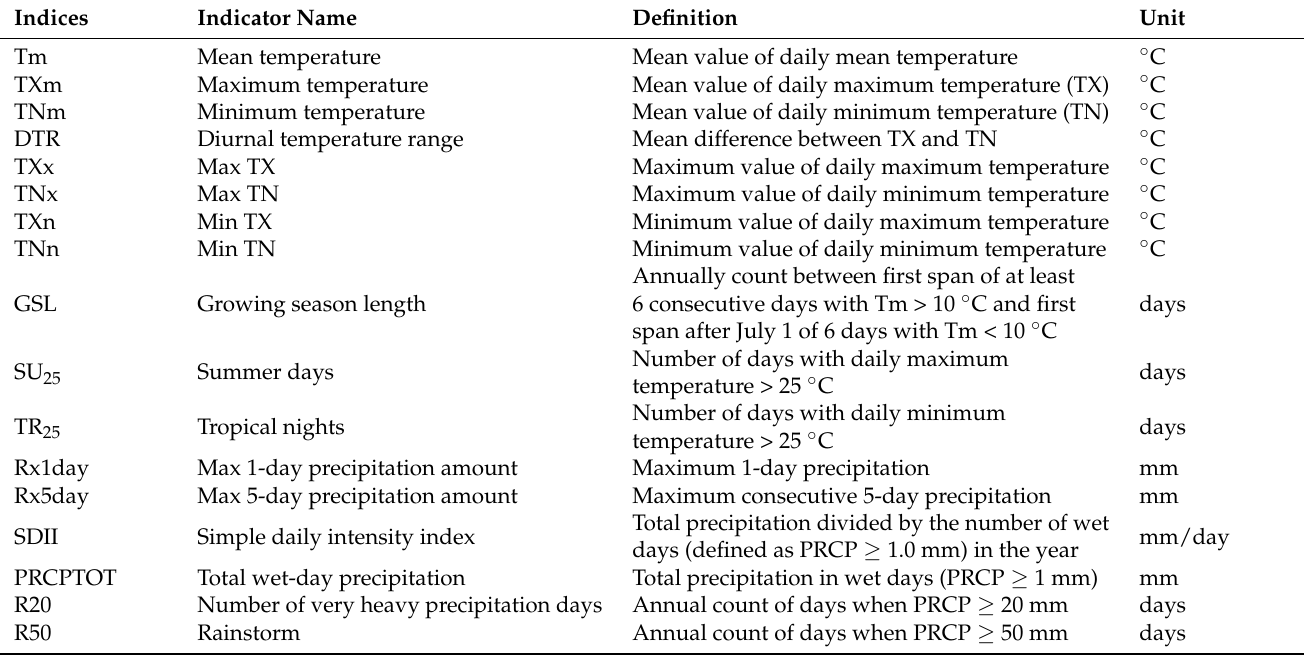
Table 2. Definitions of extreme temperature indices in this